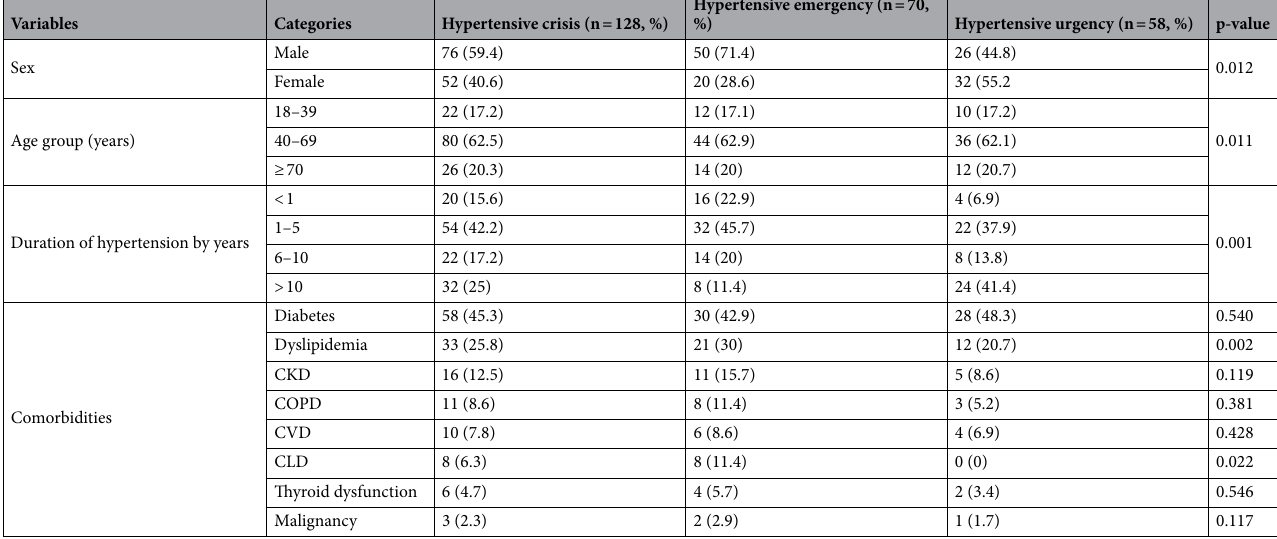
Table 1. Baseline characteristics among patients with hypertensive crises. CKD chronic kidney disease, COPD chronic obstructive pulmonary disease, CVD cardiovascular disease, CLD chronic liver